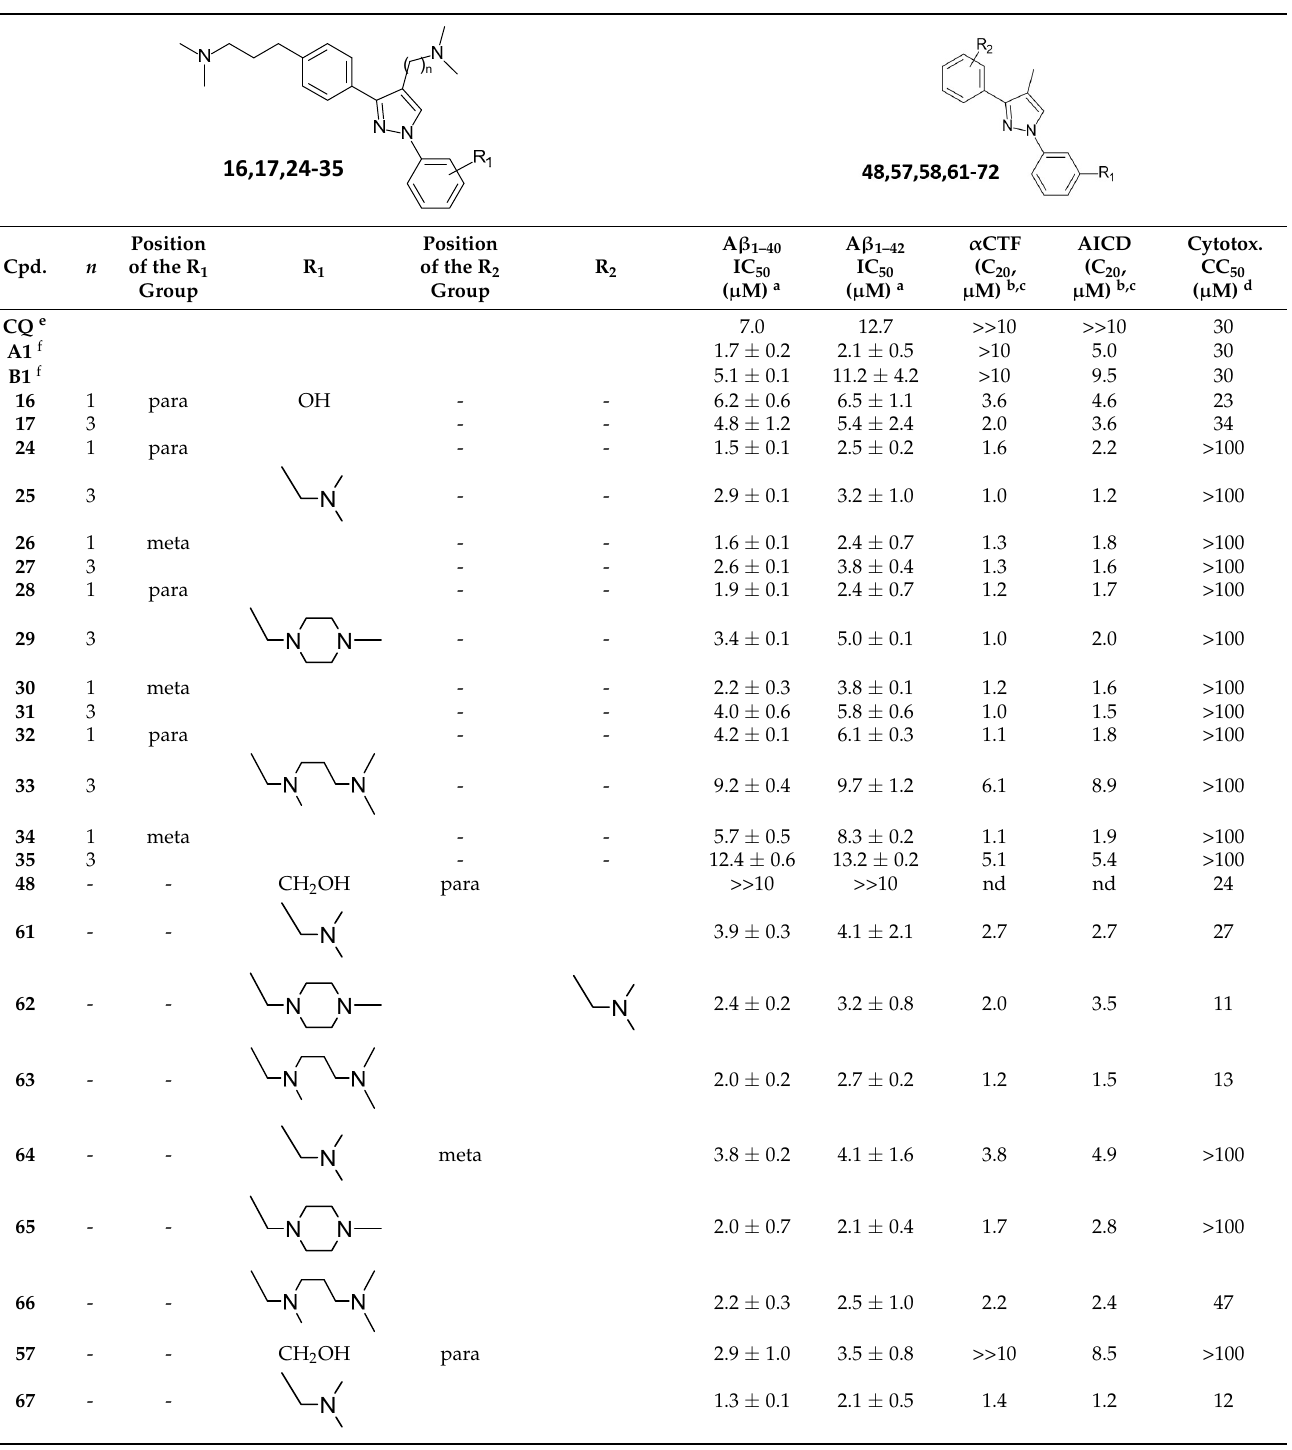
Table 1. Effects of compounds 24 – 35 , 61 – 72 on the metabolism of APP.